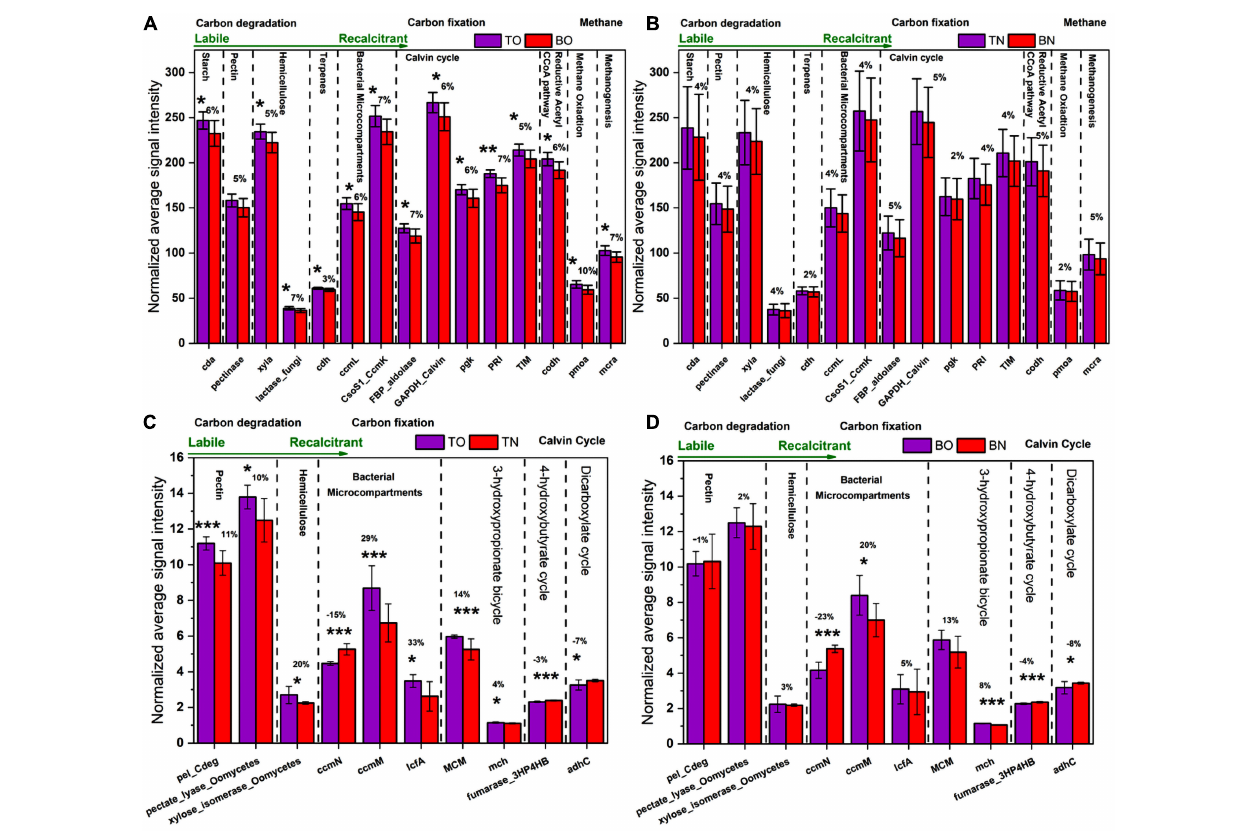
FIGURE 5 | The normalized average signal intensity of functional genes related to the carbon cycle. (A) The figure shows significantly upregulated genes at the surface sediment portion [top layer of the oyster culturing area (TO)] compared with the bottom portion [bottom layer of the oyster culturing area (BO)] of the oyster site. (B) The figure shows a comparison between the surface sediment portion [top layer of the non-culturing area (TN)] compared with the bottom portion [bottom layer of the non-culturing area (BN)] of the reference site. (C) The figure shows significantly upregulated genes at the surface sediment portion [top layer of the oyster culturing area (TO)] of the oyster site compared with the surface portion [top layer of the non-culturing area (TN)] of the reference site. (D) The figure shows significantly upregulated genes at the bottom sediment portion [bottom layer of the oyster culturing area (BO)] of the oyster site compared with the bottom portion [bottom layer of the non-culturing area (BN)] of the reference site. Error bars denote the standard deviation (SD) of the mean ( n = 16), and a % sign indicates the percent change. An asterisk indicates significant differences between groups at p <